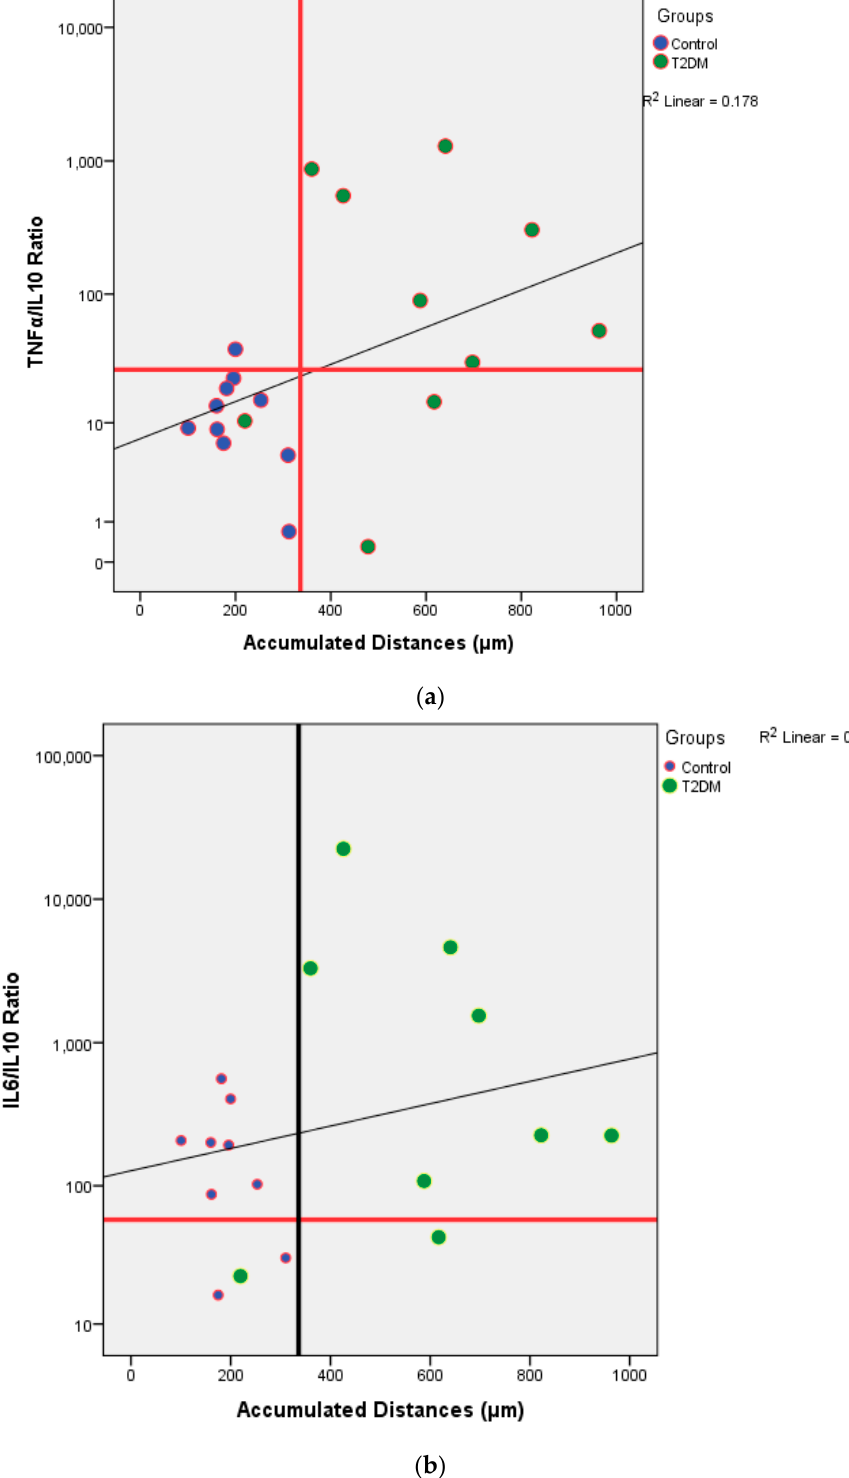
Figure 4. ( a ) The relation between the ratio of TNF- α /IL-10 and the accumulated distance; ( b ) IL-6/IL- 10.